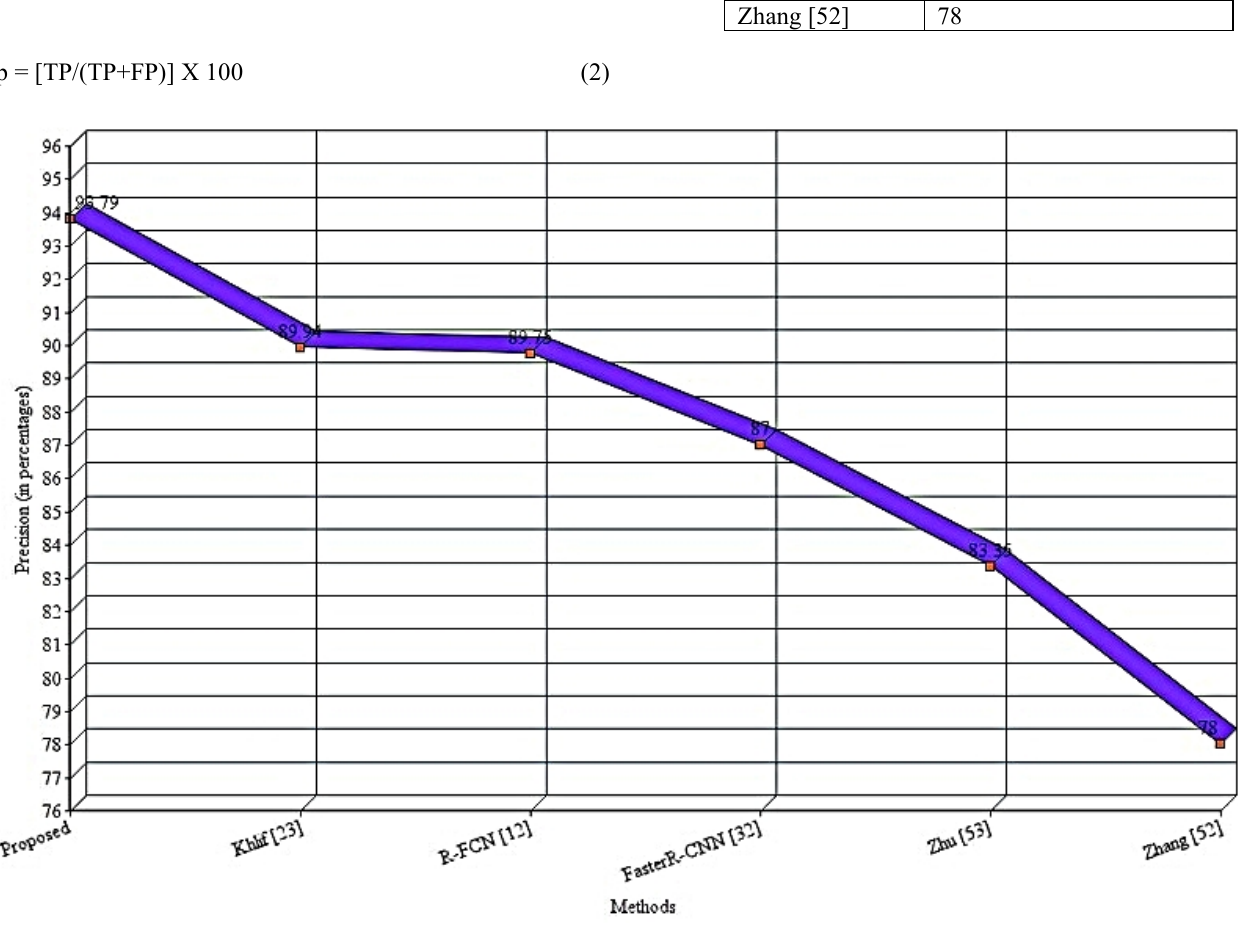
Figure 9. Comparison of precision for proposed and existing